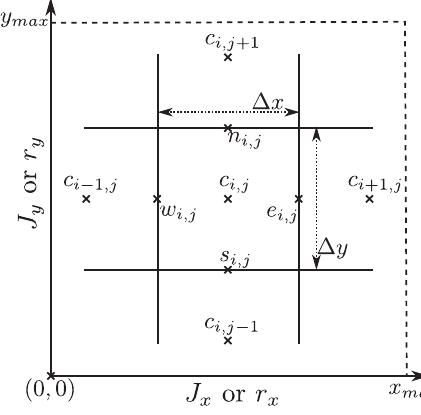
FIG. 1. Illustration of the FVM grid in P y RADISE . A uniform N × N cell grid covers the independent variables, either in the x y form of J or r , from 0 to their respective maximal values. Each i þ 1 cell in the grid has a center c · Δ x; ð j þ 1 · Δ y Þ(cid:2) , and 2 Þ 2 Þ i;j ¼ ½ð four edge points e , w , n , s , which are half a cell width or height in the respective compass directions. It follows naturally that e w , etc. i;j ¼ i þ 1 ;j